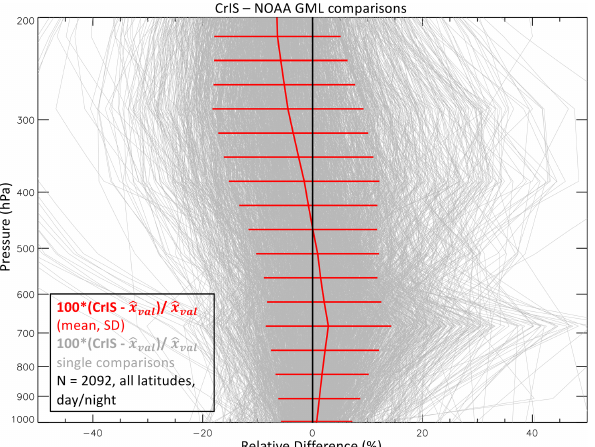
Figure 4. Relative differences (%) in single CrIS retrievals with coincident NOAA GML ˆ x val profiles (grey) and the average percent difference with 1 σ horizontal bars (red). Both day and night CrIS observations are included for coincidence search, with 1866 day and 266 night comparison pairs found.